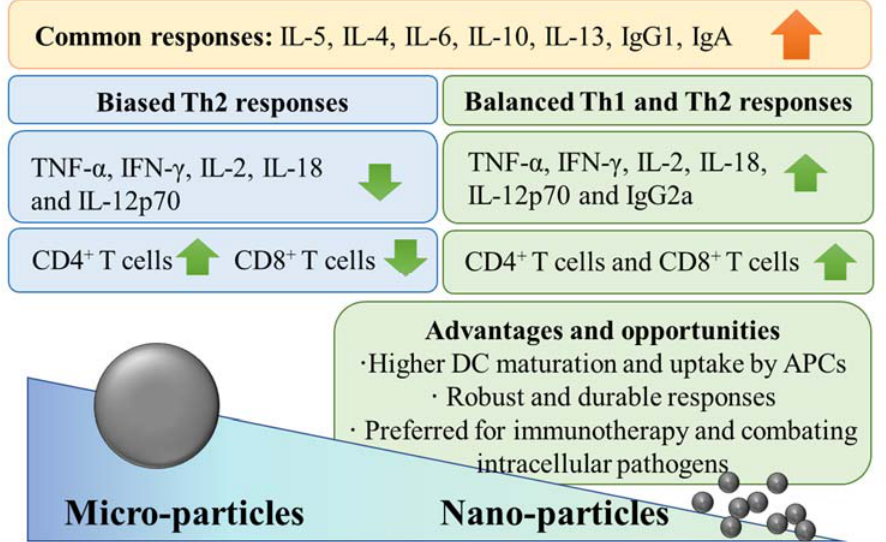
Figure 1. Generalized adjuvant effects of Al ‐ MPs compared to Al ‐ NPs.